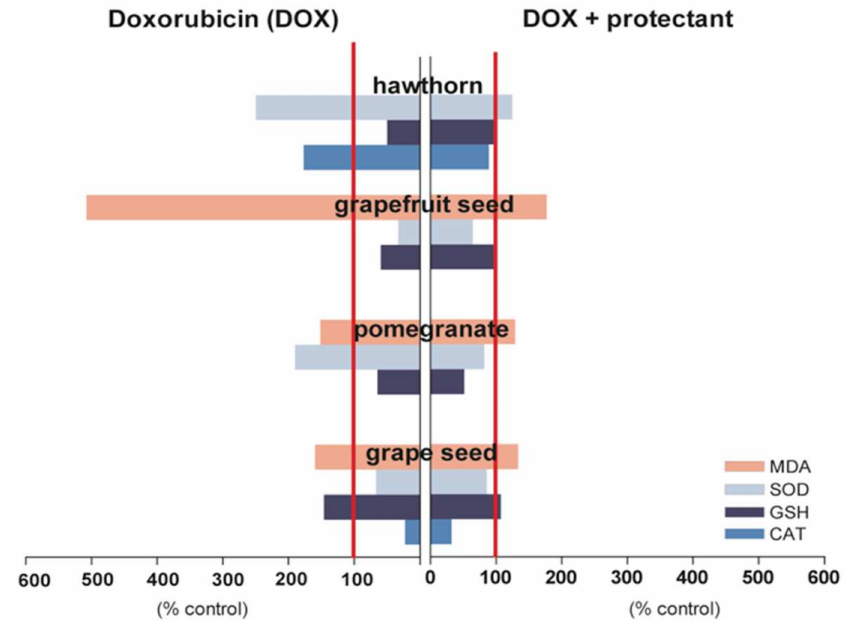
Figure 1. The oxidative-stress-associated cardiotoxic effects of DOX (left-hand side bars) are com- pared with cardioprotective activity of fruit extracts (right-hand side bars). Fruit extracts decreased MDA formation stimulated by DOX (control MDA values ranged from 7.92 to 182.65 nmol/g protein). The tested cardioprotectants restored the reduced by DOX level of GSH (control GSH values range was from 27.51 to 35.87 mg/g protein) as well as normalized activity of antioxidant enzymes SOD and CAT (100% CAT and SOD were in the range from 30.95 to 50.29 U/g protein and from 13.78 to 155.5 kU/mg protein,